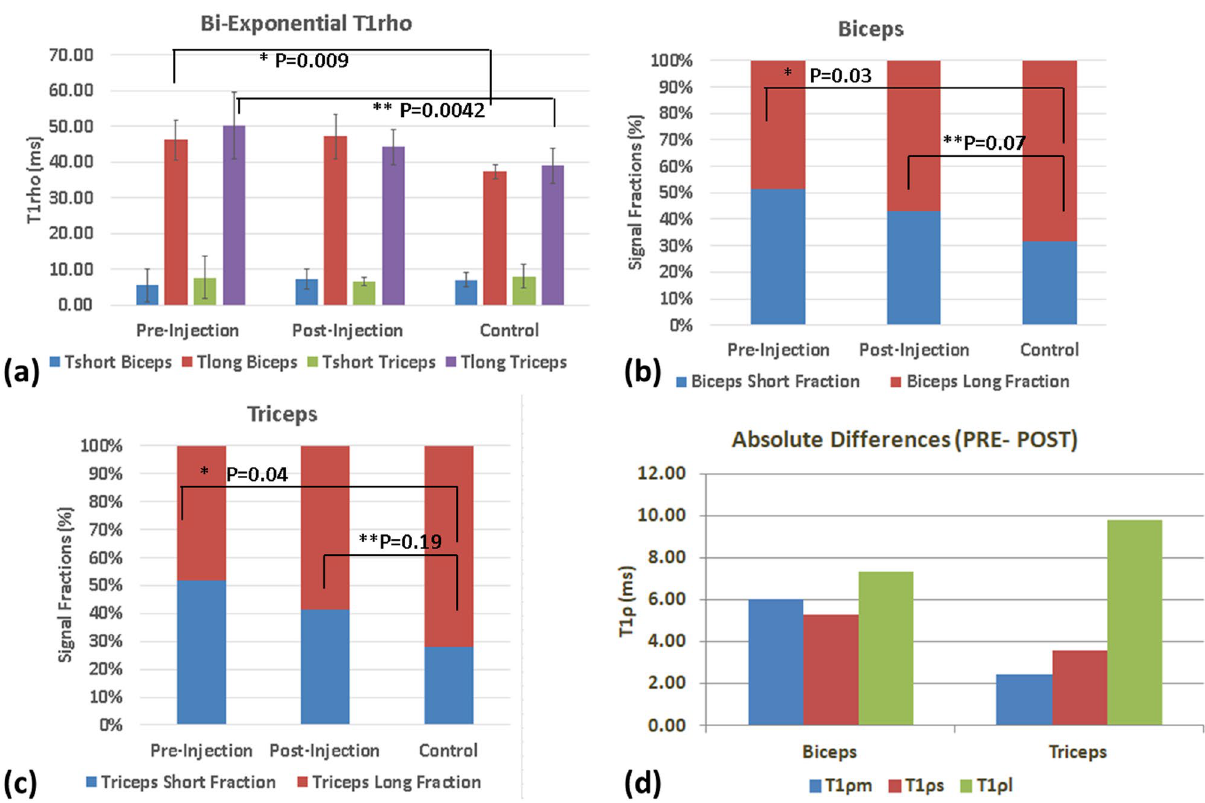
Figure 3. Comparison of mean T 1ρ values between groups. ( a ) shows bi-exponential results in biceps and triceps ROIs between patients pre- and post-treatment and controls, ( b ) shows the comparison of the signal fractions in the biceps between pre- and post-treatment and controls, ( c ) shows the comparison of the signal fractions in the triceps between pre- and post-treatment, and controls, and ( d ) shows absolute differences in T 1ρm , T 1ρs , T 1ρl between pre- and post-treatment in the biceps and triceps.